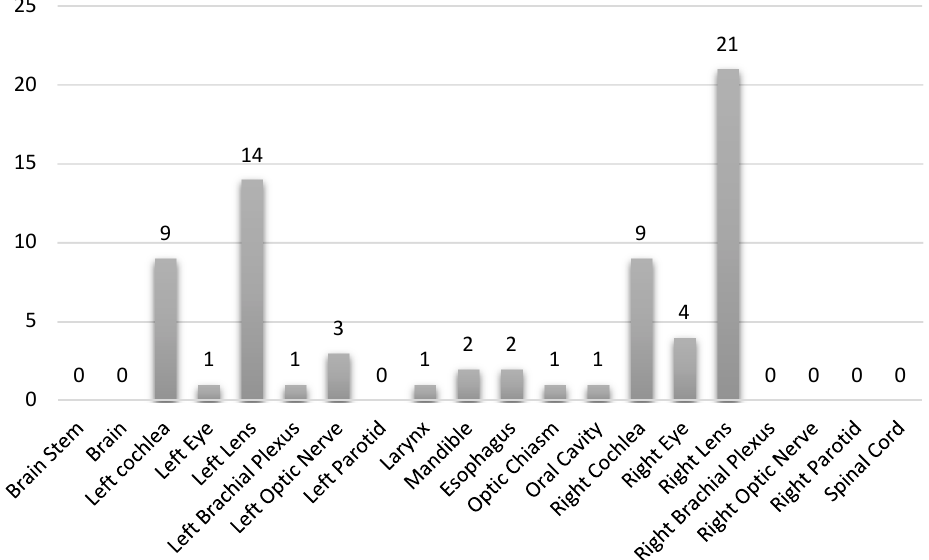
Figure 3. Number of patients with relative dose difference between NCCT and CCT greater than 2% for critical structures in nasopharynx treatment plans.